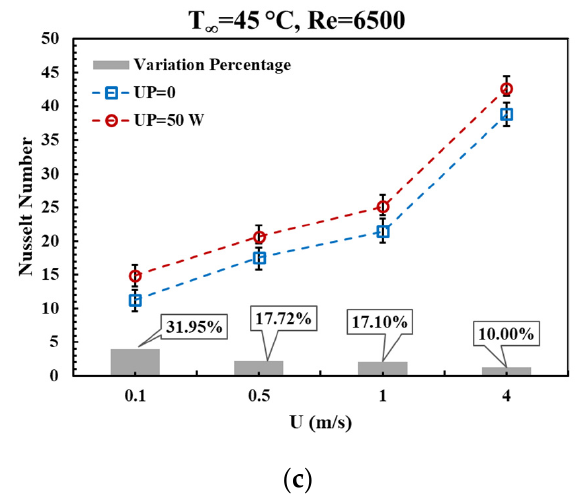
Figure 15. The variations of Nusselt number against U at T ∞ = 45 ( ◦ C ) and Reynolds numbers of ( a ) Re = 2166, ( b ) Re = 4333, and ( c ) Re = 6500. The results are presented in a no-vibration state (UP = 0) and in the presence of vibration with ultrasonic power of 50 Watts (UP = 50